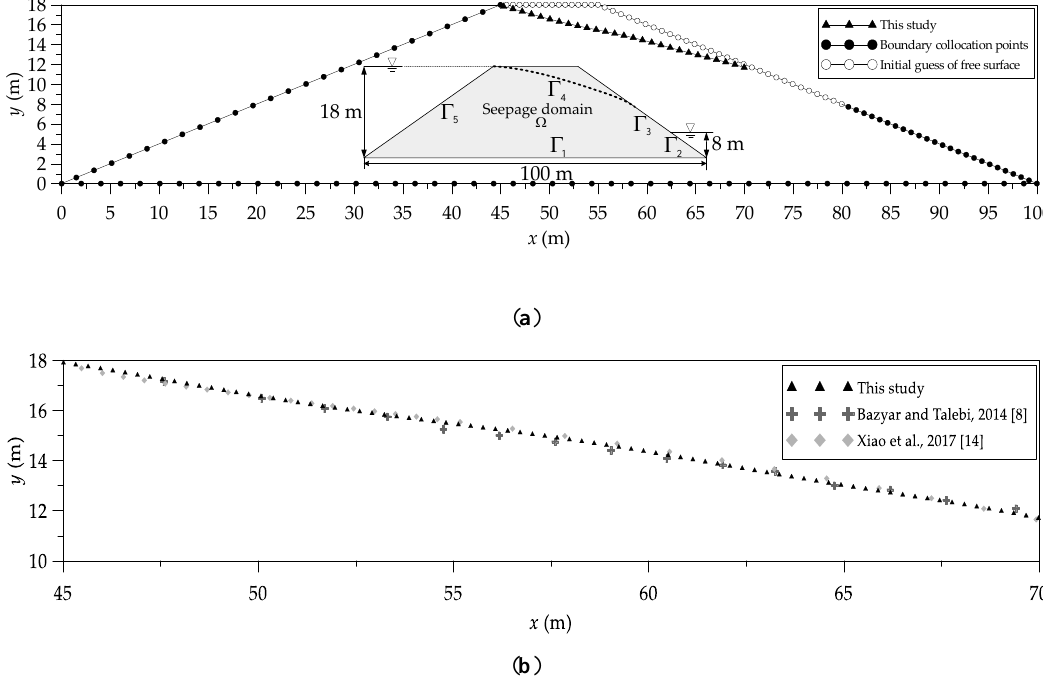
Figure 8. The cross section of the homogeneous earth dam for the analysis.